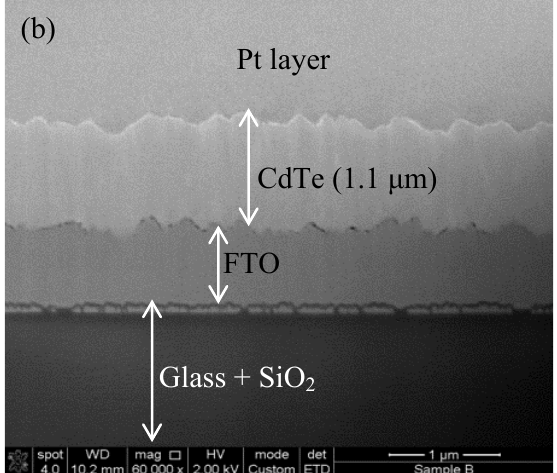
Figure 9. ( a ) Theoretical estimation of CdTe layer thickness and ( b ) a cross section